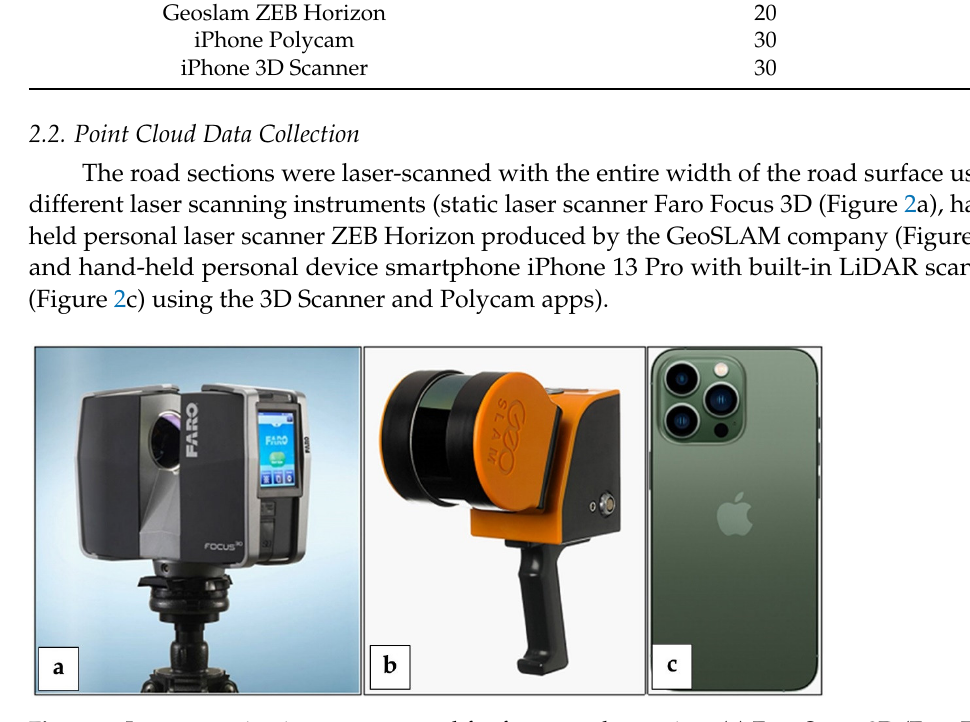
Figure 2 . Laser scanning instruments used for forest road mapping: ( a ) Faro Scene 3D (Faro Tech- nologies Ltd., Rugby, UK), ( b ) GeoSLAM ZEB Horizon (GeoSLAM Ltd., Nottingham, UK), ( c ) iPh- one 13 Pro (Apple Inc., Cupertino, CA, USA)